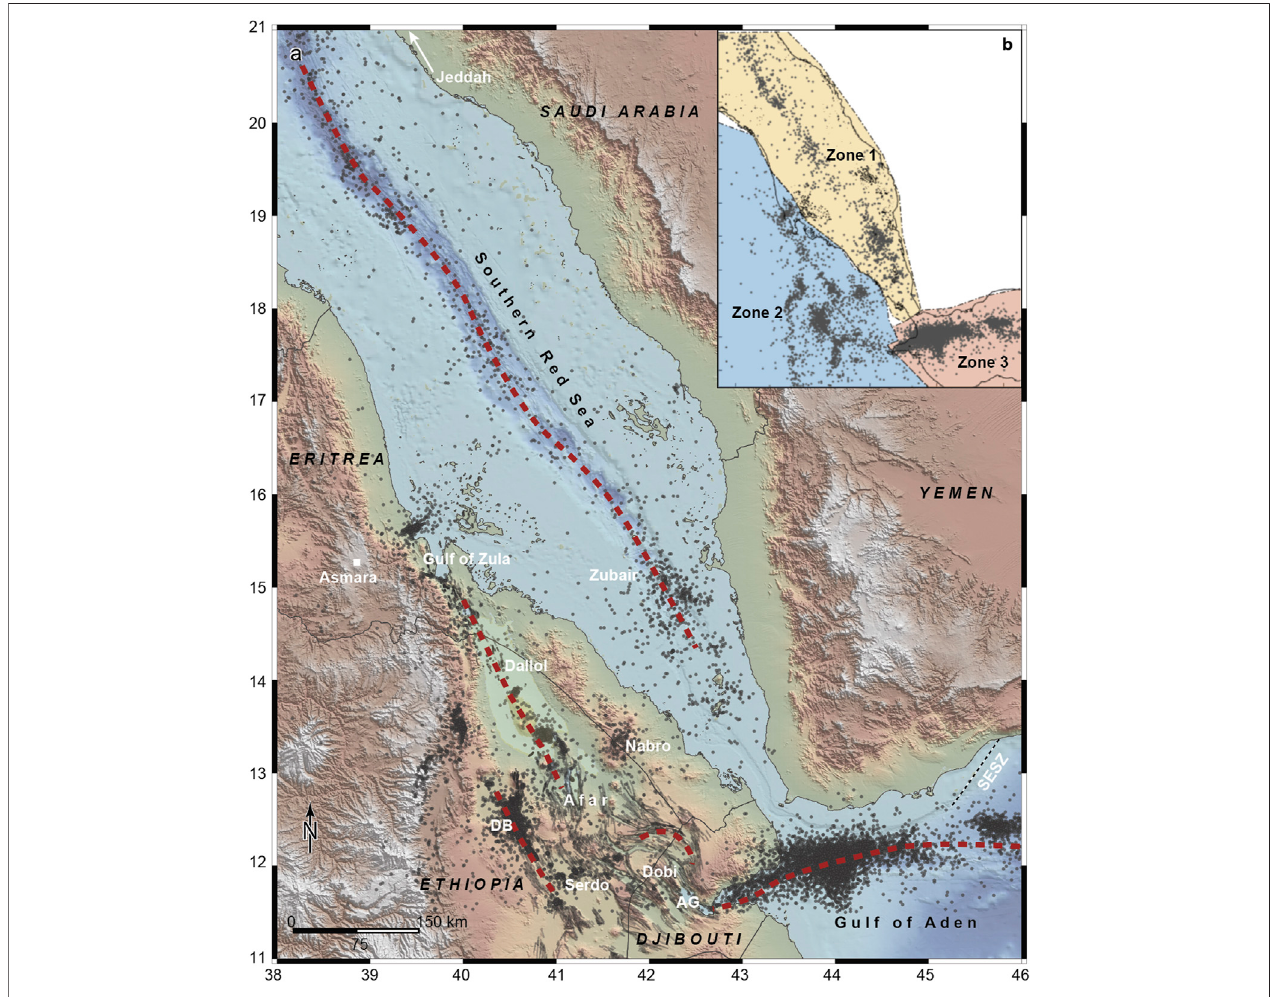
FIGURE1| MapofthesouthernRedSea,Afar,andGulfofAden(SAGA)region. (A) EarthquakelocationsfromtheISCcatalogueareshownasblackdots,country borders as thin black lines and plate boundaries in red dashed lines. (B) The earthquake swarm analysis was carried out separately for three different zones (zone 1: southern Red Sea, zone 2: Afar, and zone 3: Gulf of